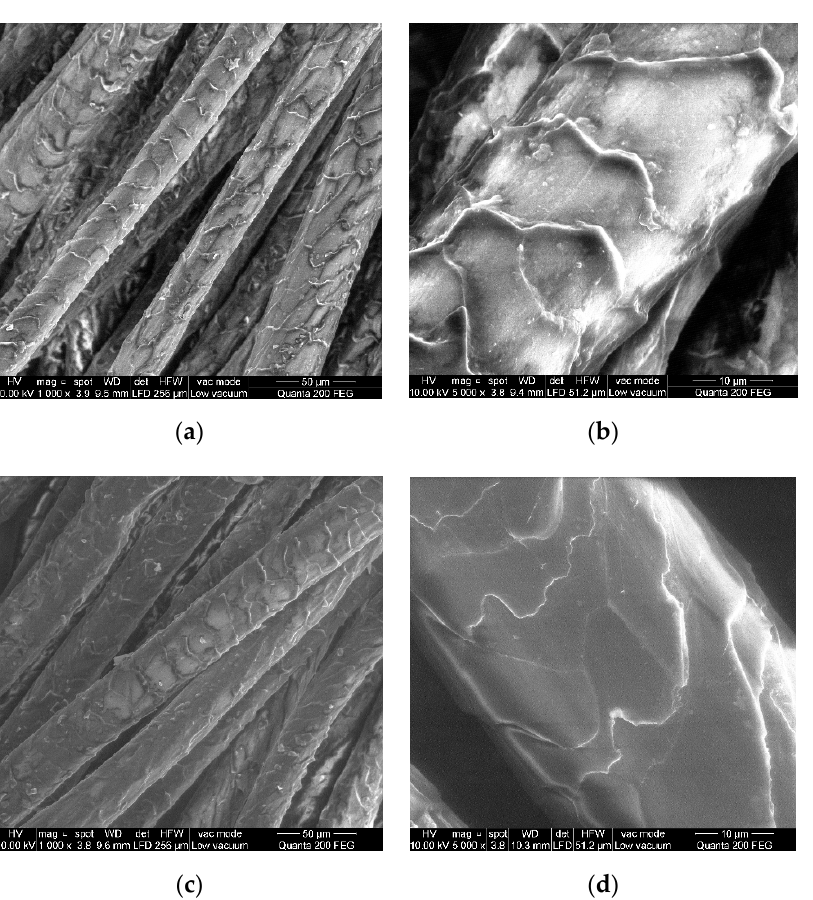
Figure 3 . SEM images of ( a ) natural woolen fibers, magnification 1000×; ( b ) natural woolen fibers, Figure 3. SEM images of ( a ) natural woolen fibers, magnification 1000 × ; ( b ) natural woolen fibers, magnification 5000×; ( c ) regenerated woolen fibers, magnification 1000×; ( d ) regenerated woolen magnification 5000 × ; ( c ) regenerated woolen fibers, magnification 1000 × ; ( d ) regenerated woolen fibers, magnification 5000×. fibers, magnification 5000 × .